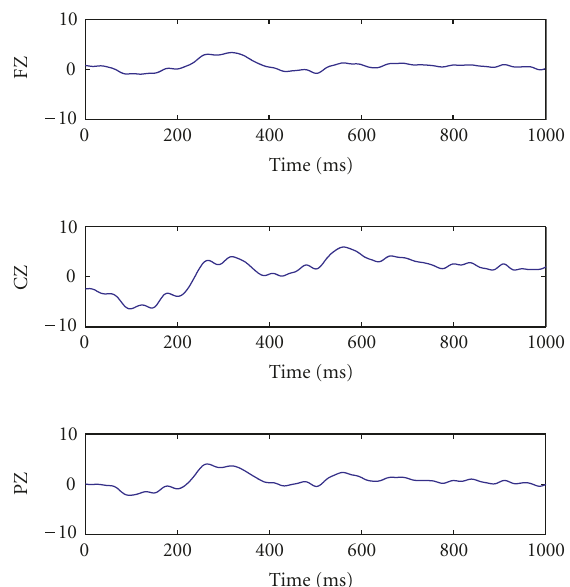
Figure 9: Three channel ERPs of a control subject obtained by av- eraging 40 related events.